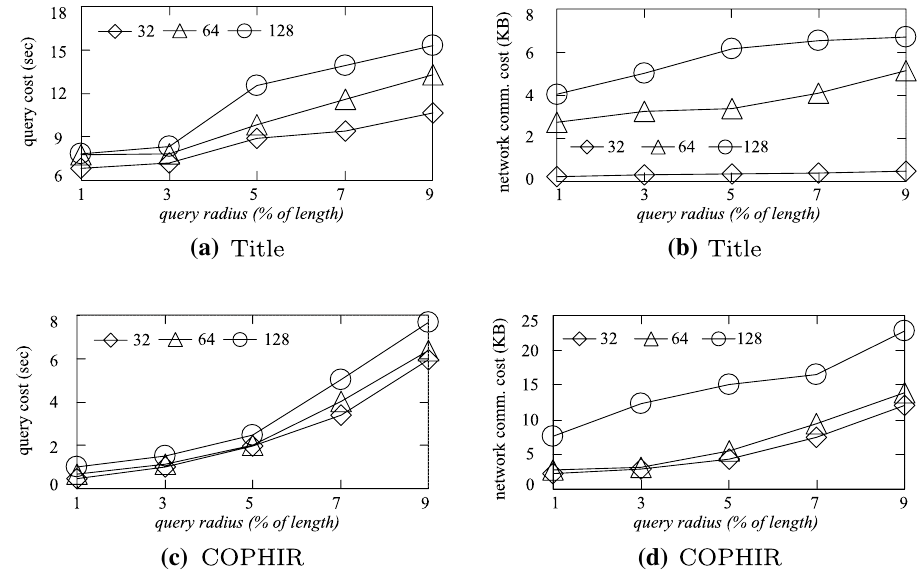
Fig. 7 Effect of query radius